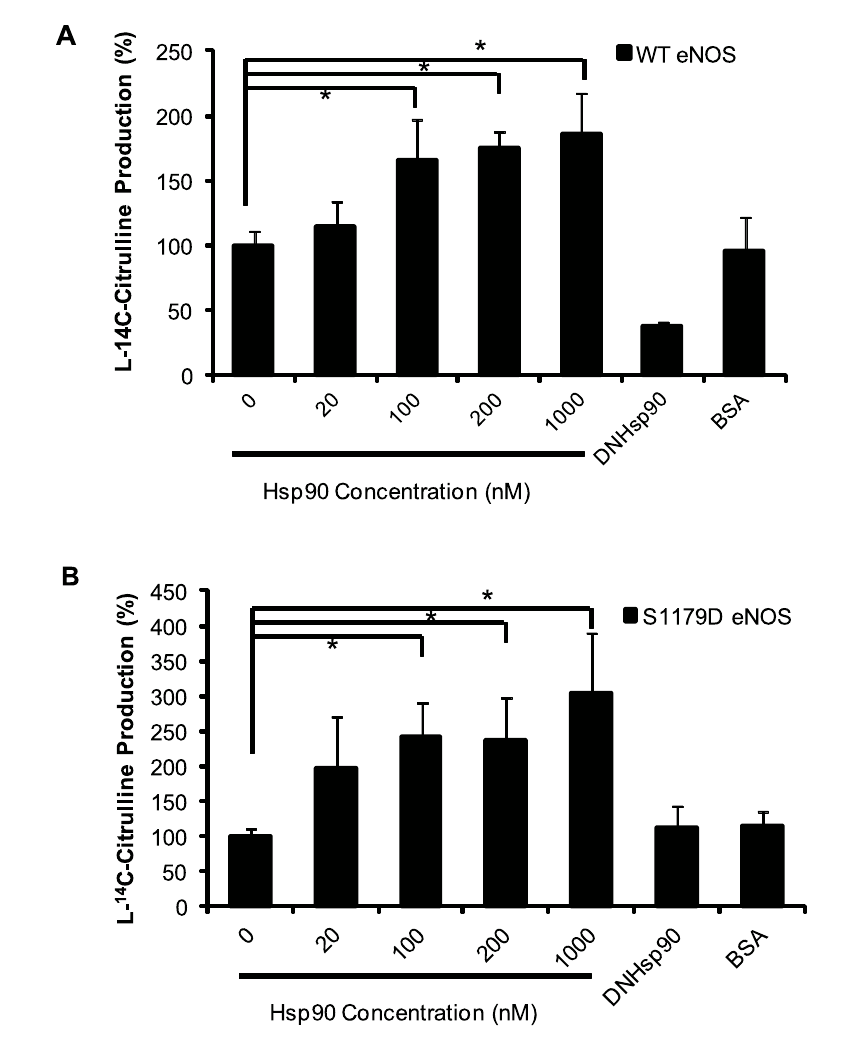
Fig 1. Hsp90 enhances both WT eNOS and S1179DeNOS activity. Purified WT eNOS and S1179DeNOS activities were assayed by monitoringthe conversionof L-14C-arginineto L-14C-citrulline in the presence of different concentration of Hsp90. (A) Hsp90enhancedWT eNOS as a dose-dependentlyand these enhancements were inhibited by dominant mutant Hsp90 (DNHsp90)(n = 5, * P < 0.05,Hsp90 treatment groupscompared to control). (B) Moreover, Hsp90 had higherenhancement effect on S1179D eNOS than it had on WT eNOS (n = 5, * , P < 0.05Hsp90 treatment groups comparedto control).